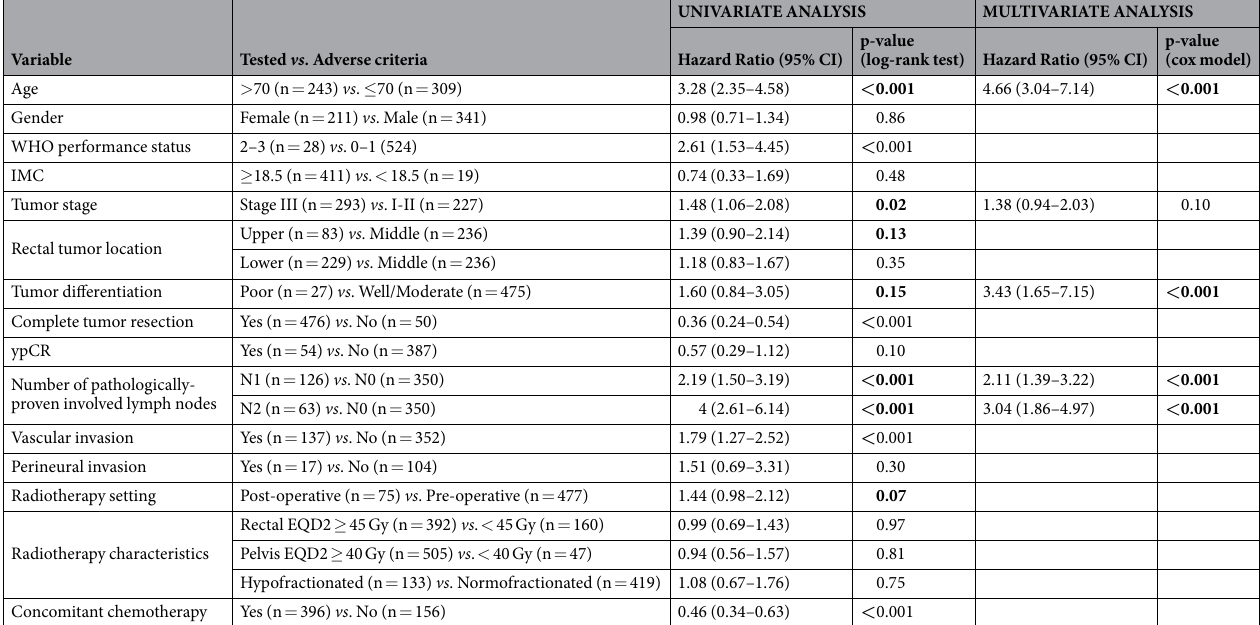
Table 5. Prognostic factors for overall survival in patients undergoing tumor resection (n = 552 patients). 95% CI: 95% confidence interval; ypCR: Pathological complete response. EQD2: 2GY-per-fraction equivalent dose. All p-values ≤ 0.2 in univariate analysis were tested in multivariate analysis, except correlated variables (correlation with p < 0.001). Only bold typed values were tested in multivariate analysis. The sum of sub- populations might be inferior to 552 in some cases because of missing